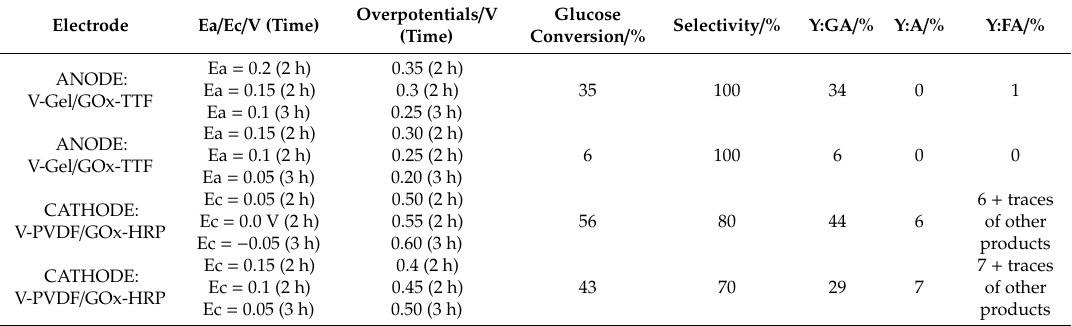
Table 2. NMR analysis of reaction mixtures after 7 h of enzymatic electrodes operation in half-cell